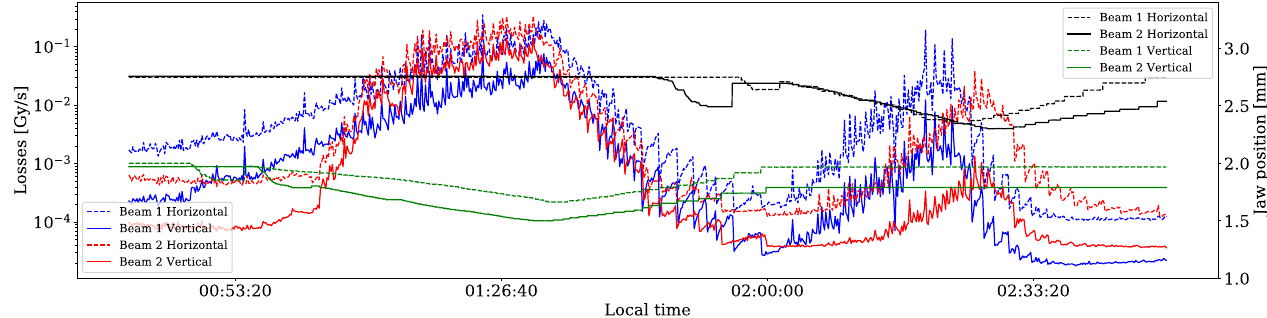
FIG. 3. Beam losses from the IC-BLM monitor. Beam 1 and beam 2 are shown in blue and red, respectively, and jaw positions during fill 6052 reported in Table III. Scraping is first performed on the vertical plane of the two beams at the same time; afterward, scraping is performed on the horizontal plane.